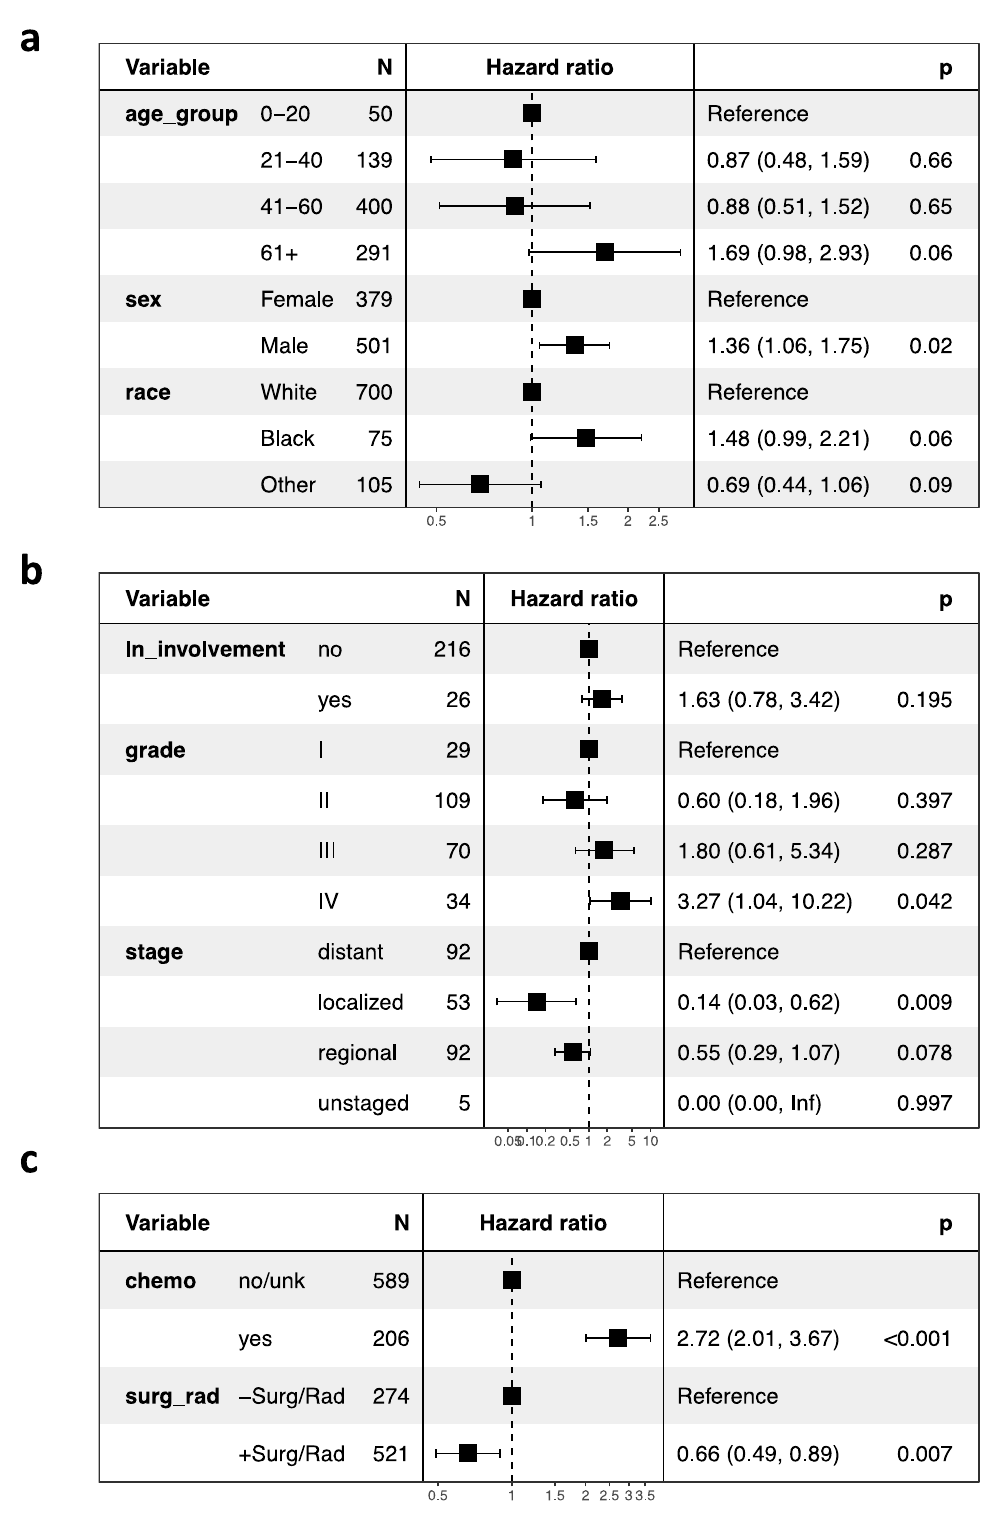
Figure 1. Cox proportional hazard ratios and forest plots of ( a ) patient demographics, ( b ) tumor characteristics, and ( c ) treatment regimen of the study population. Abbreviations: ln, lymph node; chemo, chemotherapy; surg, surgery; rad, radiation. Values in parentheses indicate the 95% confidence intervals.